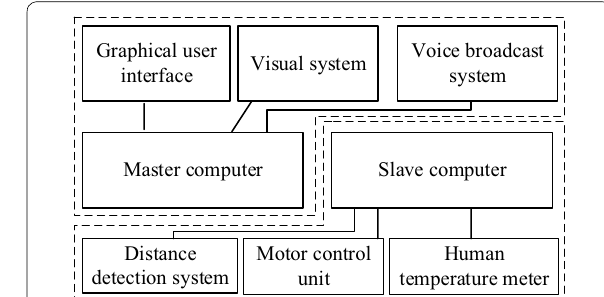
Figure 5 Framework of the SHUYU robot control system